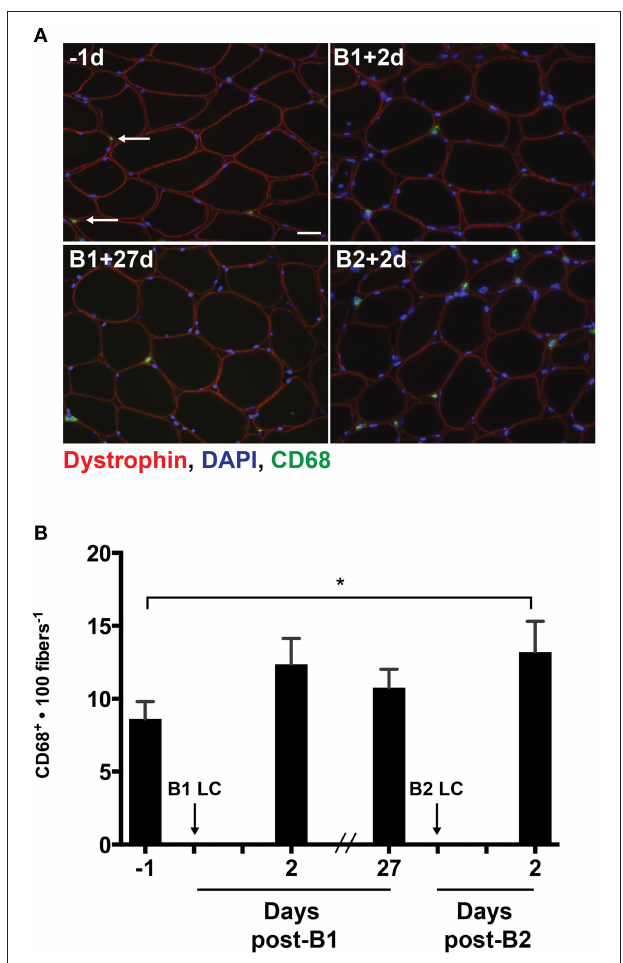
FIGURE 3 | Muscle-infiltrating CD68 + macrophages. (A) Eight micrometer thick muscle cross-section stained for dystrophin (red), CD68 (green), and DNA (blue). All four images were taken from muscle samples from the same subject 1 day before bout 1 (B1) of damaging lengthening contractions (LC) (-1d), 2 days after B1 (B1 + 2d), 27 days after bout 1 (B1 + 27d) and 2 days after bout 2 (B2) (B2 + 2d). Arrows indicate a CD68 + macrophage as evidenced by CD68 immunoreactivity surrounding a blue nucleus. (B) Intramuscular CD68 + macrophage enumeration per muscle fiber before and 2 days following the first (B1) and second bout (B2) of damaging lengthening contractions (LC). * Indicates significant difference (One-way repeated measures ANOVA with Tukey’s HSD, p < 0.05 ). Scale bar = 20 µ